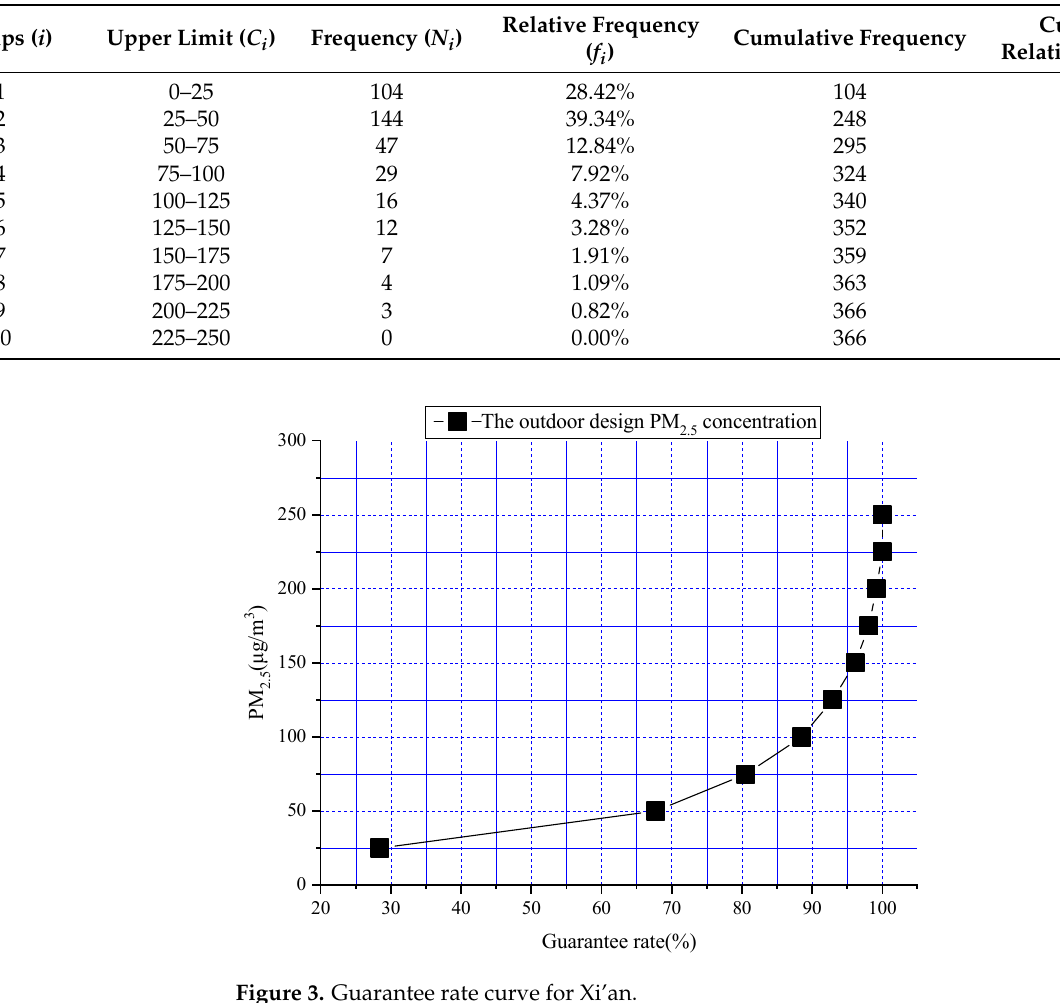
Table 2. Grouping interval and cumulative relative frequency for Xi’an.